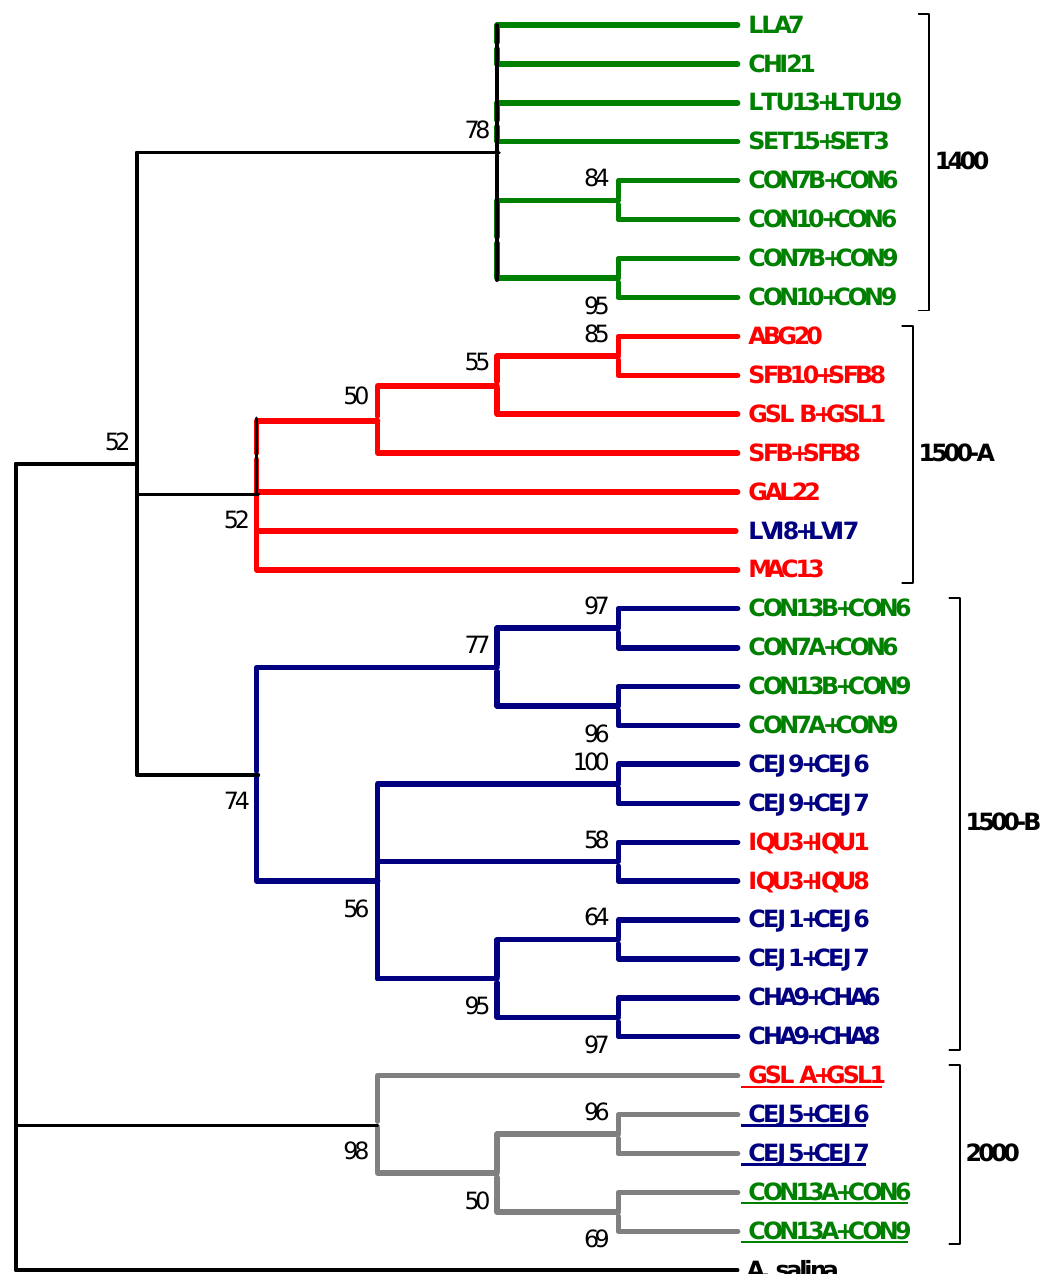
Figure 2. Consensus maximum parsimony phylogeny (50% majority rule of 38 most parsimonious trees, tree length = 1224) of concatenated p26 and ITS1 A. franciscana haplotypes. Values at nodes indicate bootstrap support based on 1000 pseudoreplicates. The order of concatenation is denoted as p26 + ITS1. Designations lacking a plus sign indicate concatenation of sequences from the same individual. The recovered groups (1400, 1500-A, 1500-B, 2000) are used as tags for the observed p26 alleles (see text). Colors (green, red, blue) correspond to the respective mitochondrial clades (see Figure 1). Haplotypes of the distinct 2000 group (gray) are underlined. The phylogeny is rooted with A.